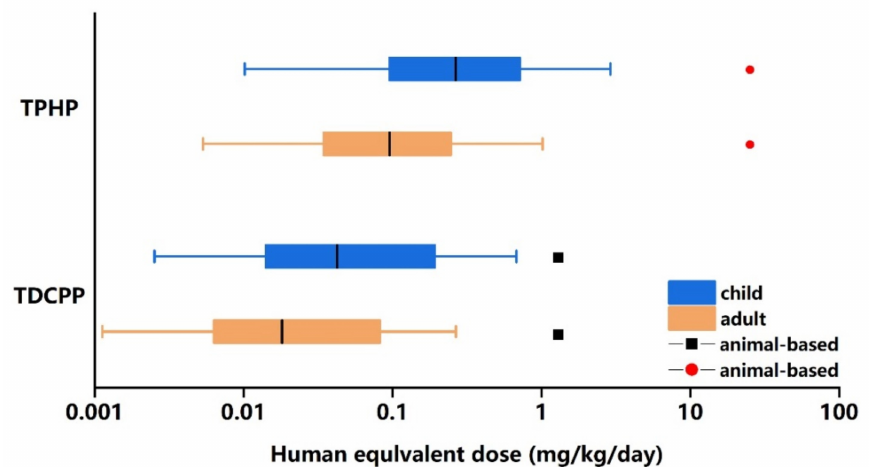
Figure 4. Box and whisker plots represent overall liver based HEDs of TPHP and TDCPP obtained by merging HEDs of each assay. Different percentiles of HED for each population were calculated (P2.5, P25, P50, P75 and P97.5). Black squares and red dots represent HED values derived from experiments on